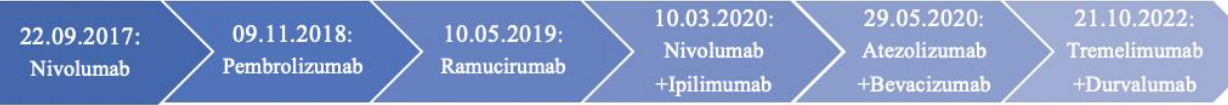
Figure 1. Timeline of FDA-approved monoclonal antibodies for unresectable hepatocellular carcinoma .